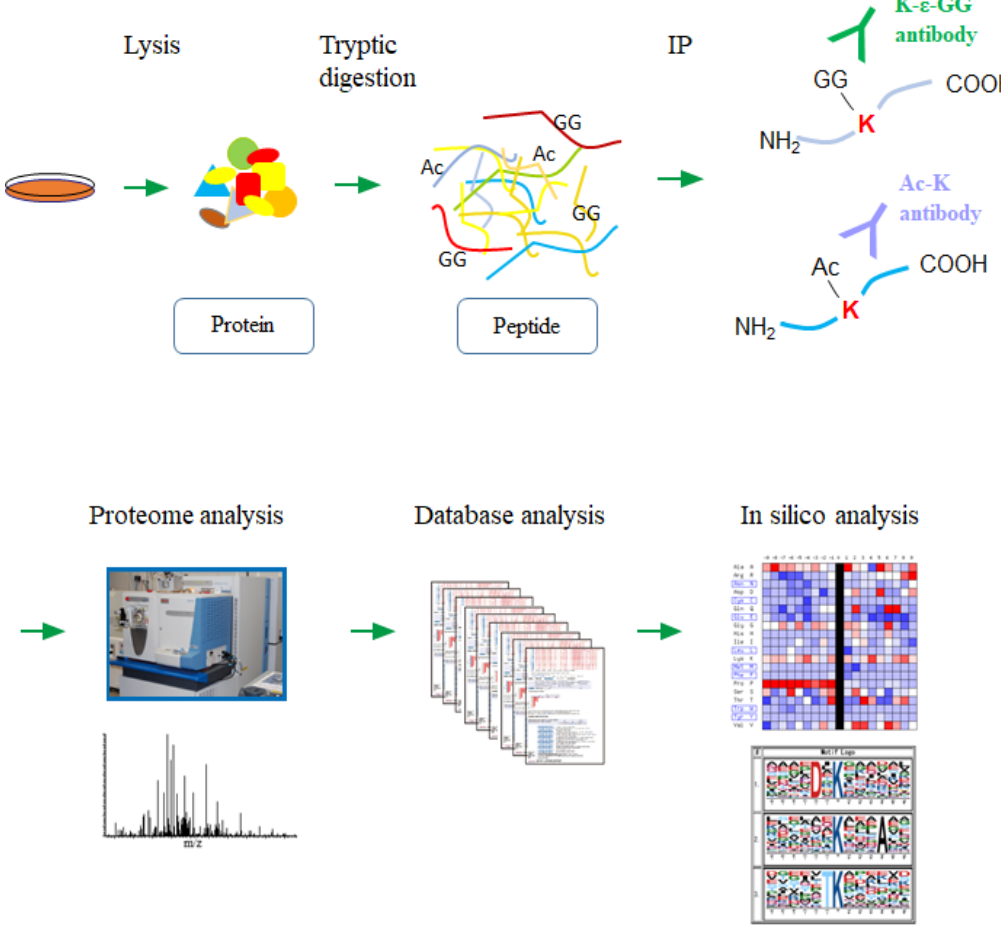
Figure 1. A schematic workflow for the large-scale lysine modification proteome analysis. Each cancer cell lysate was digested with trypsin, and the lysine-modified peptides were immunoprecipitated using the specific antibodies. Regarding the ubiquitination, the enzymatically generated diglycine remnants on the side-chain of modified lysine residues (K- ε -GG) were recognized by the corresponding antibody. The enriched peptides were then analyzed by the high-resolution nanoLC-MS/MS system, followed by an integrative computational analysis.